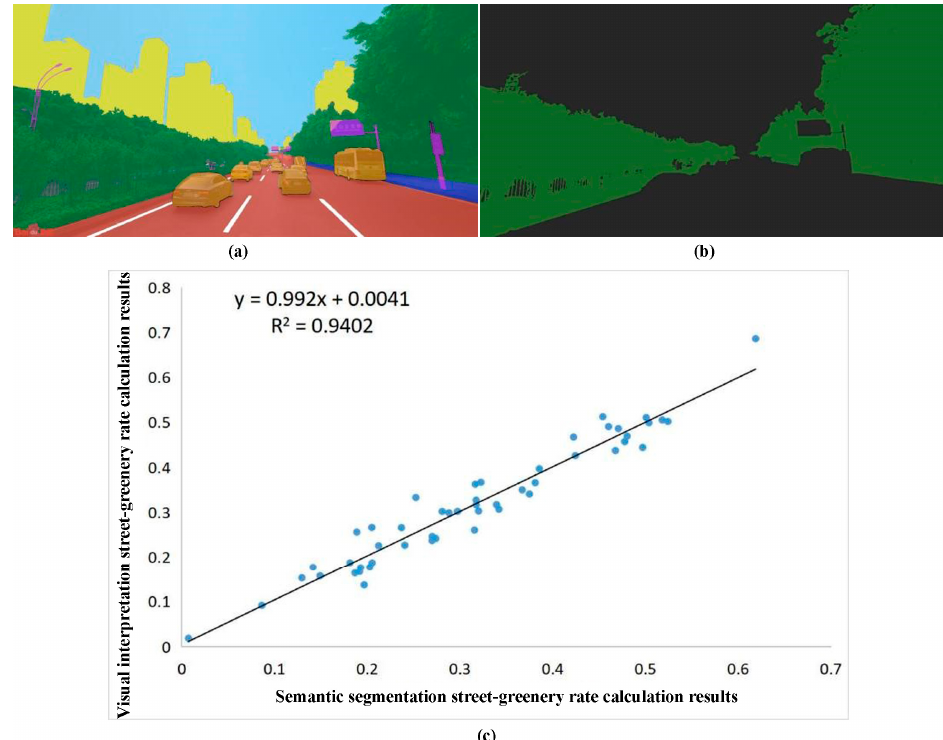
Figure 10. Comparison of two SGR calculation methods: ( a ) Semantic segmentation result; ( b ) Visual interpretation result; ( c ) Scatter plot between two methods.